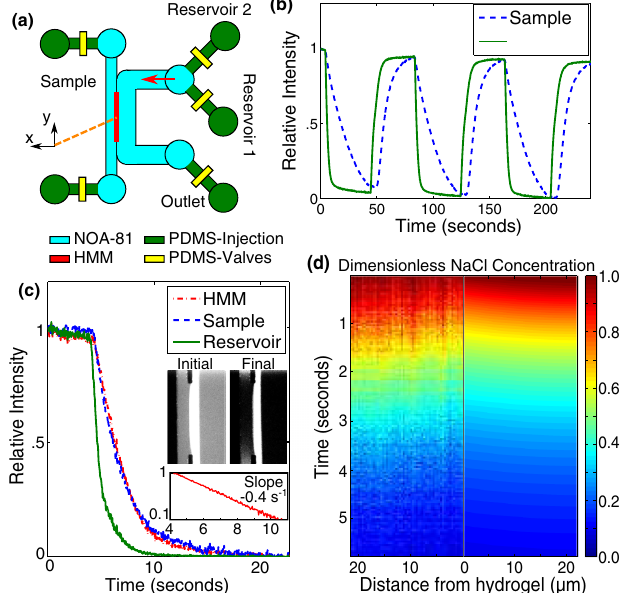
FIG. 5. (a) Device geometry for prompt reservoir solution swapping using PDMS valves and rapid dialysis in the sample channel using an HMM. Panel (b) and Video 4: Swapping between 250-mM-NaCl (bright) and 0-mM-NaCl (dark) solu- tions in a 150 - (cid:1) m -wide sample channel, with a fluorescent NaCl indicator. (c) Swapping time is greatly decreased by decreasing sample-channel width (here, 23 (cid:1) m wide). Inset graph: Semilog plot of HMM intensity shows exponential decay of salt concen- tration in HMM. Panel (d) and Video 5: Observed dynamics of NaCl concentration along the x axis of the sample channel are well predicted by the one-dimensional diffusion